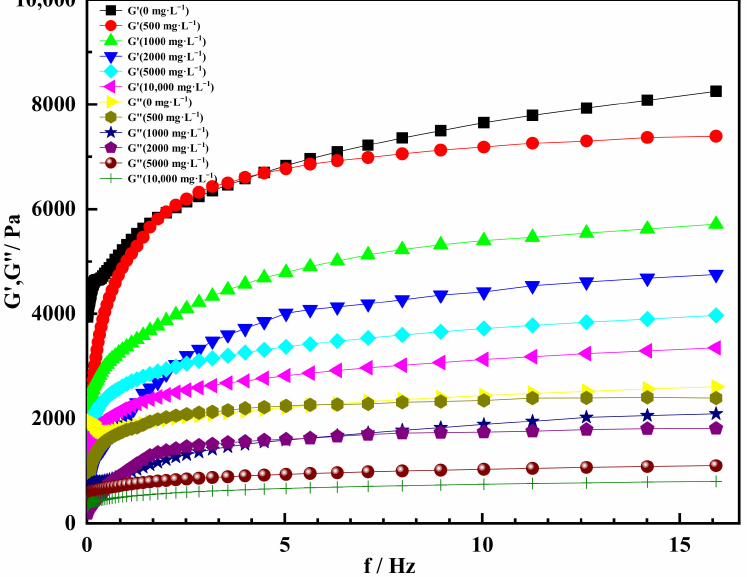
Figure 15. Storage modulus and loss modulus varied with scanning frequency at different concentra- tions of divalent salt